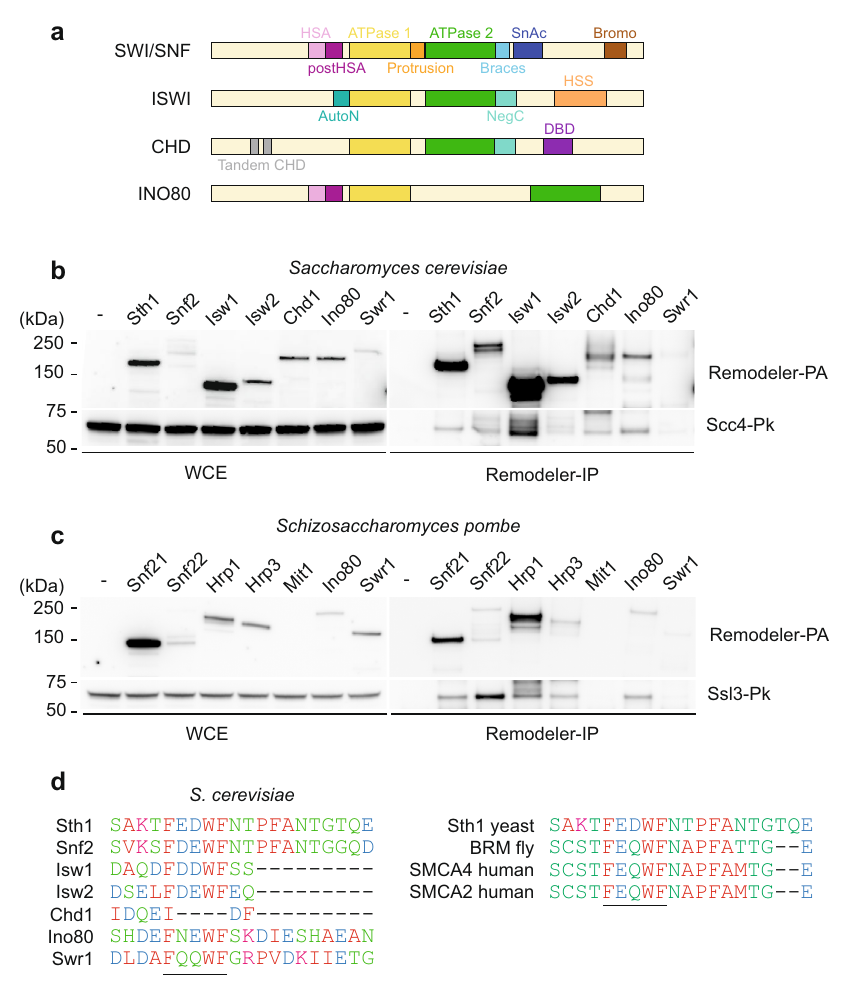
Fig. 5 | Widespread cohesin loader interactions with chromatin remodelers. a Domain organization of the ATPase subunits of the four remodeler families. b Interactions between the S. cerevisiae remodeler ATPase subunits, pulled down via protein A tags, and the cohesin loader, detected by immunoblotting against Scc4. c As in b , but precipitating the ATPase subunits of S. pombe chromatin